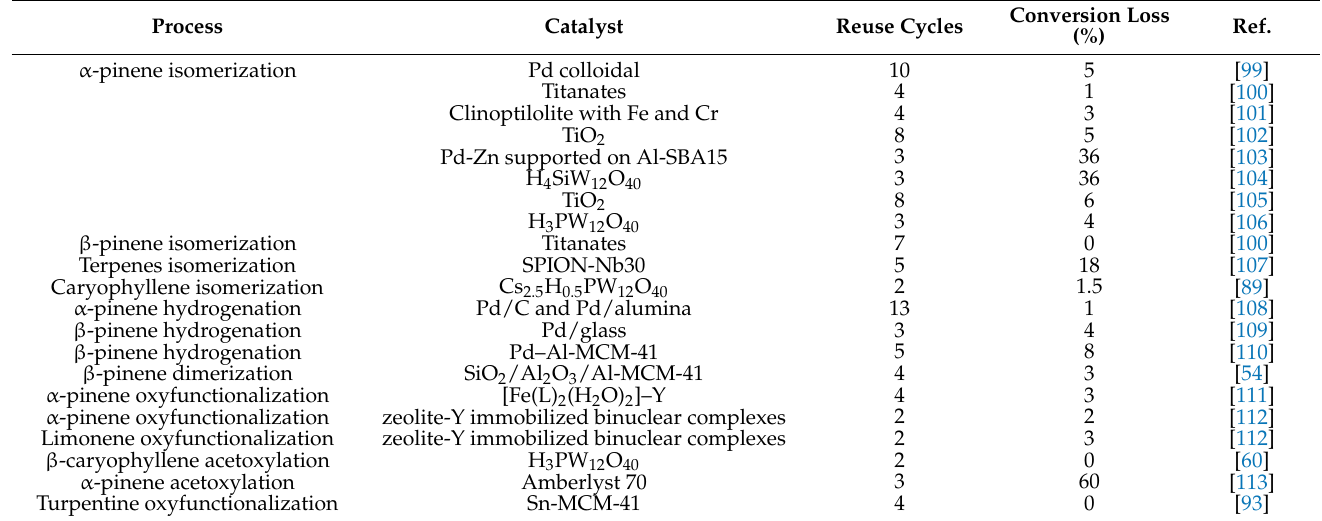
Table 5. Catalyst reuse and conversion loss in terpene conversion